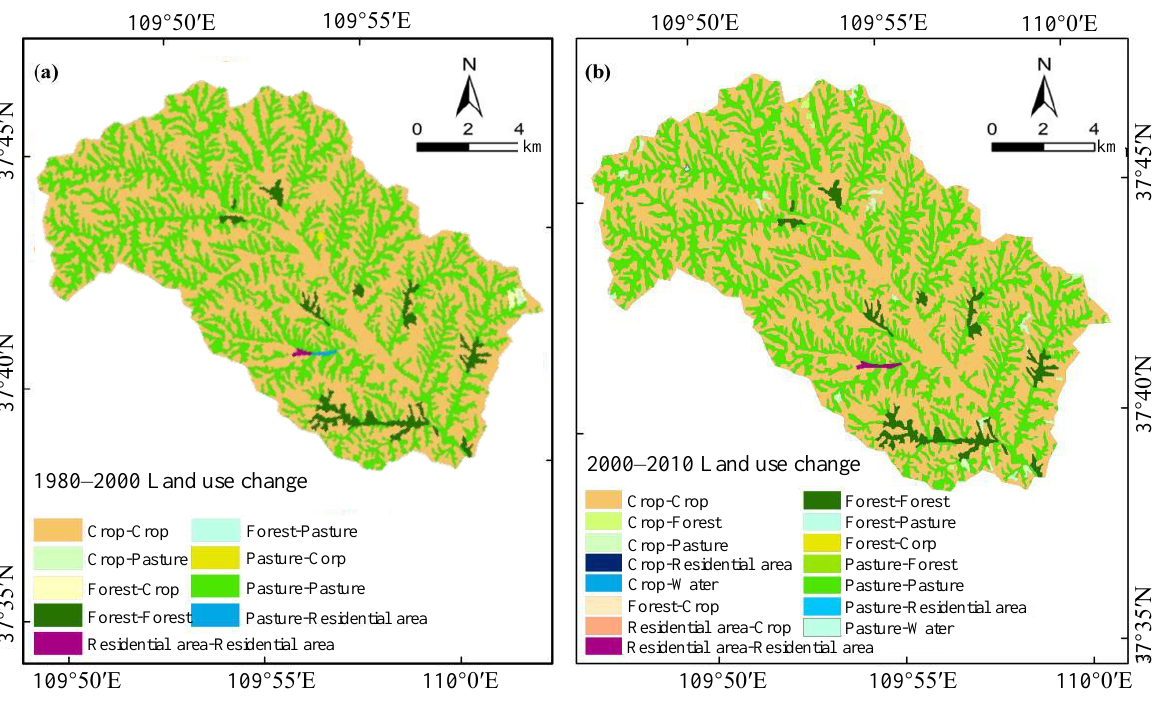
Figure 6. Variation of land transfer in the Chabagou River Watershed 1980–2000 ( a ) and 2000–2010 ( b